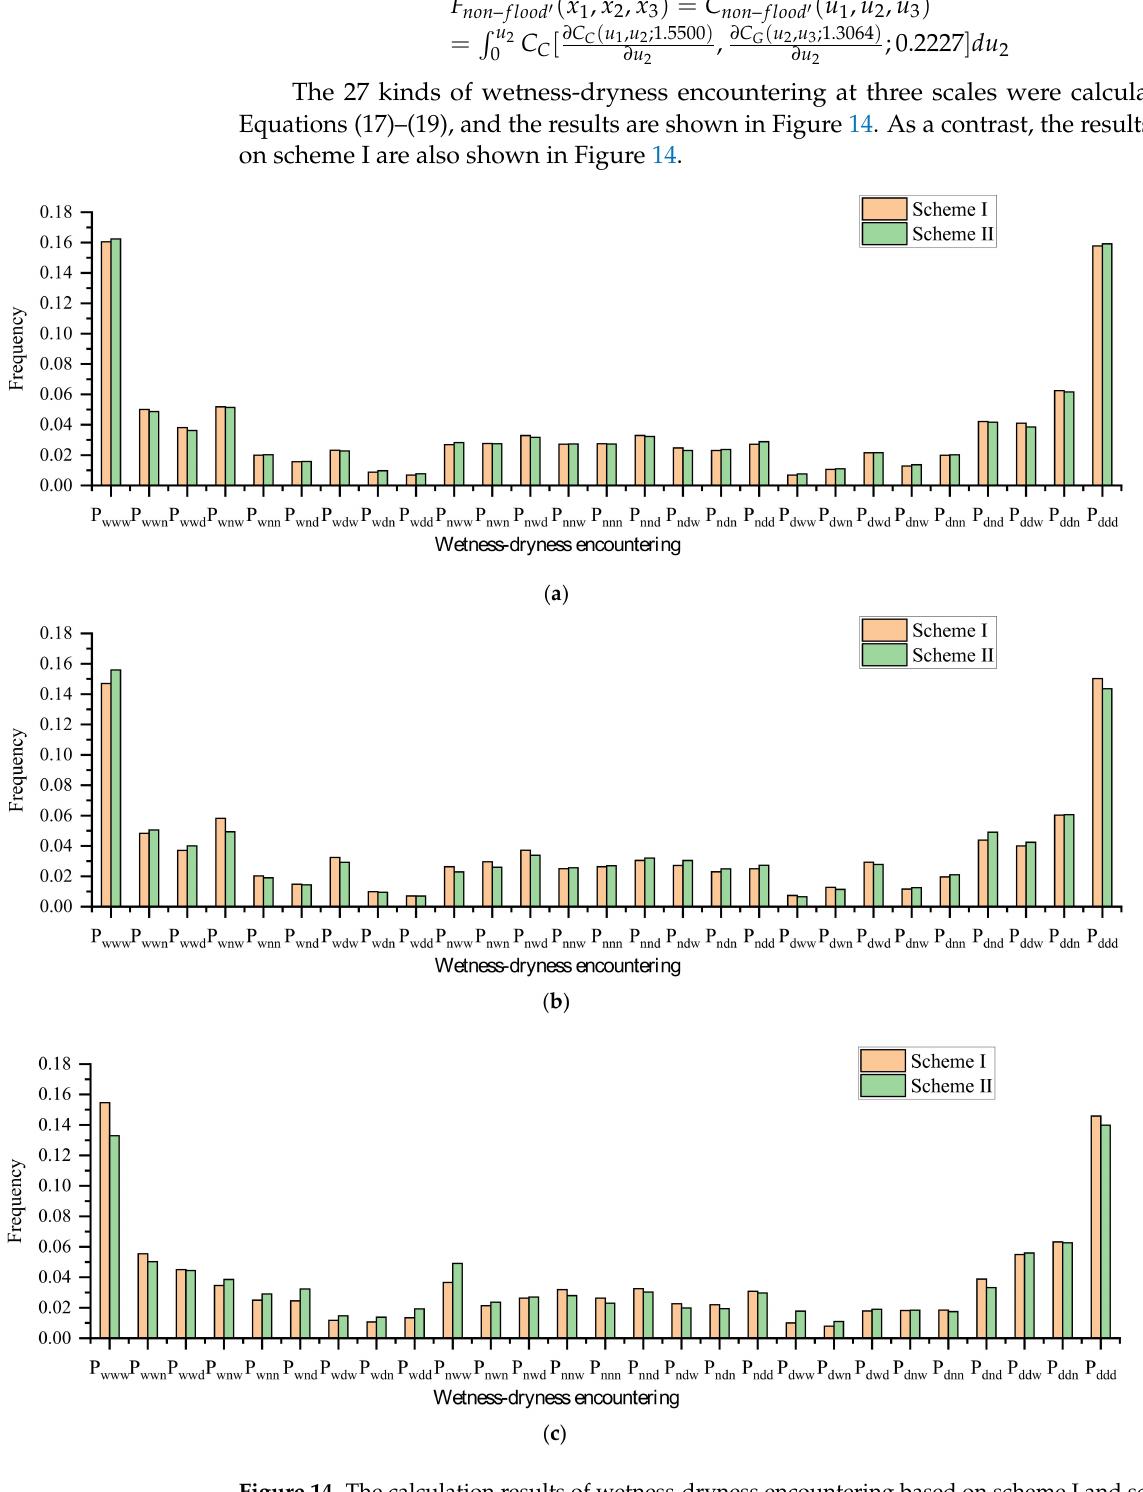
Figure 14. The calculation results of wetness-dryness encountering based on scheme I and scheme II of marginal distributions fitting at three scales: ( a ) is under the annual scale; ( b ) is in flood season; and ( c ) is in non-flood